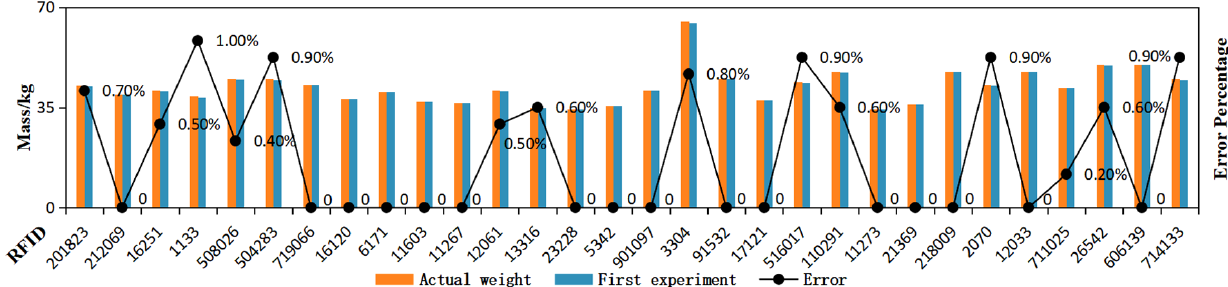
Figure 23. Data plot of the second experiment.